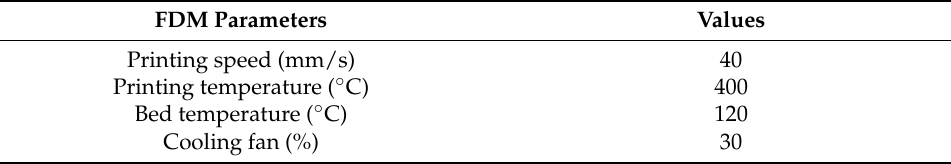
Table 1. Manufacturing parameters of the FDM machine.